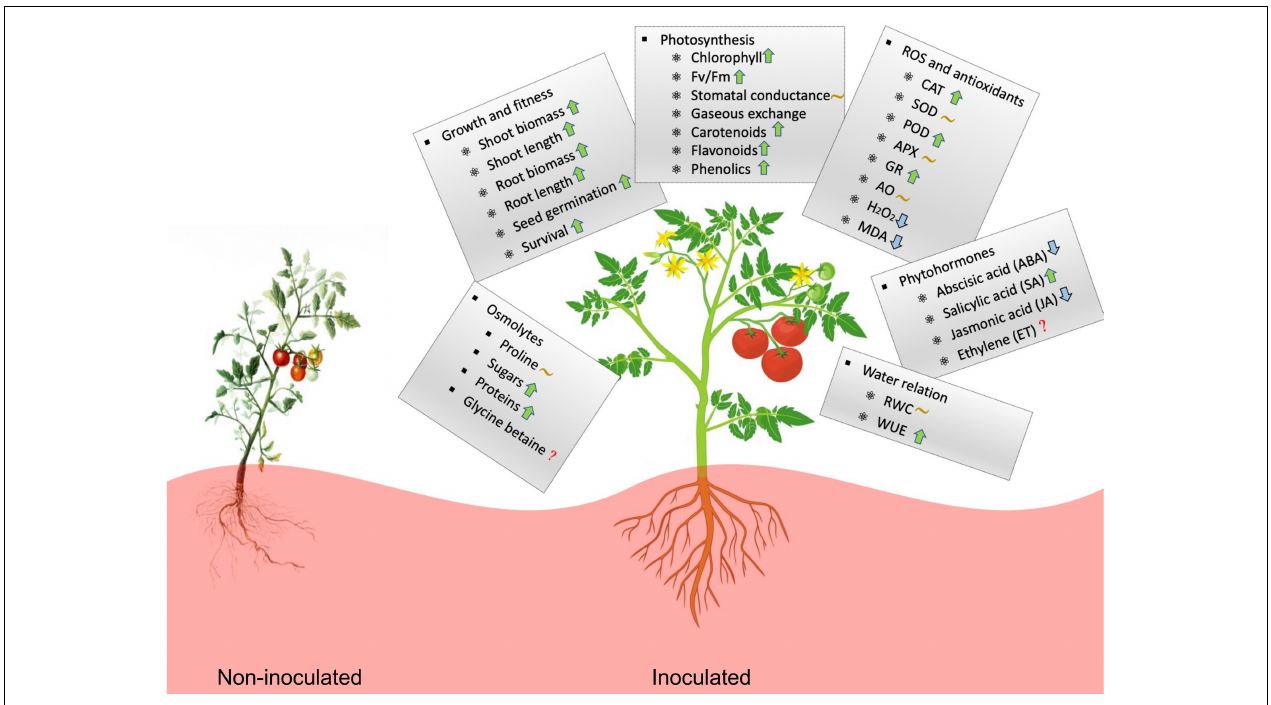
FIGURE 7 | Illustration of the effects of microbial inoculation on plant physiological activity and stress tolerance under high temperature. The upward arrow ( ↑ ) indicates increase of the value for microbial-treated plants compared to non-treated plants whereas, downward arrow ( ↓ ) indicates decease, wavy line ( ∼ ) indicates the effect is variable and the question mark (?) unavailable